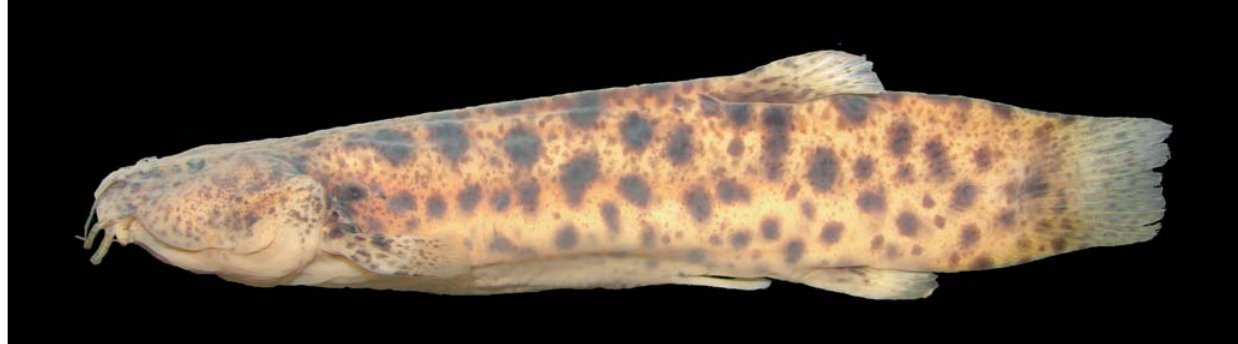
Fig. 1. Trichomycterus igobi , MPEG 13352, holotype, 90.1 mm SL. Lateral view of right side (photograph inverted).